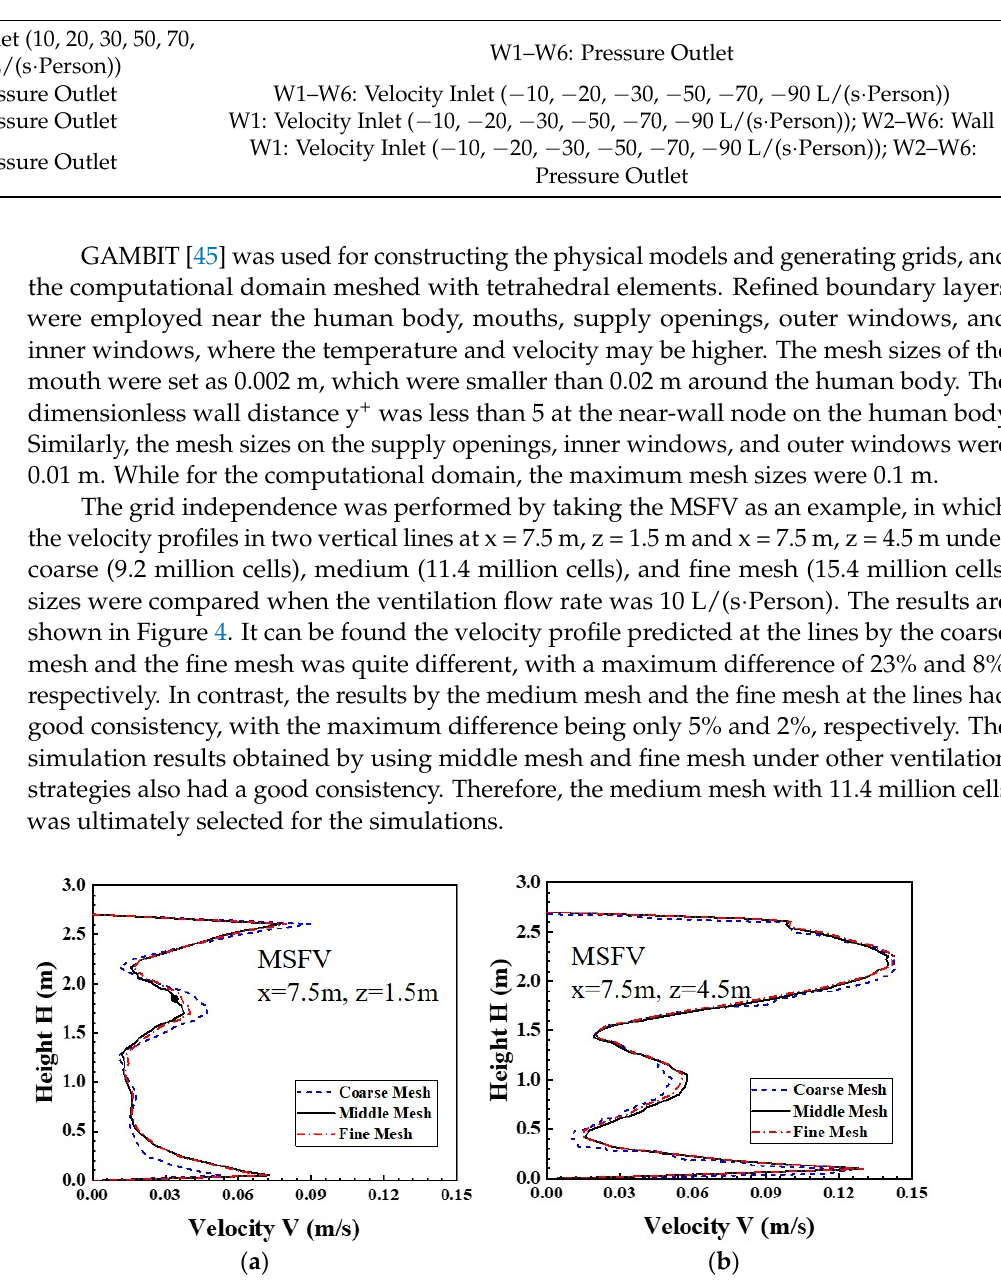
Figure 4. Velocity profiles in a vertical line at two lines under different mesh sizes. ( a ): x = 7.5 m, z = 1.5 m; ( b ): x = 7.5 m, z = 4.5 m.